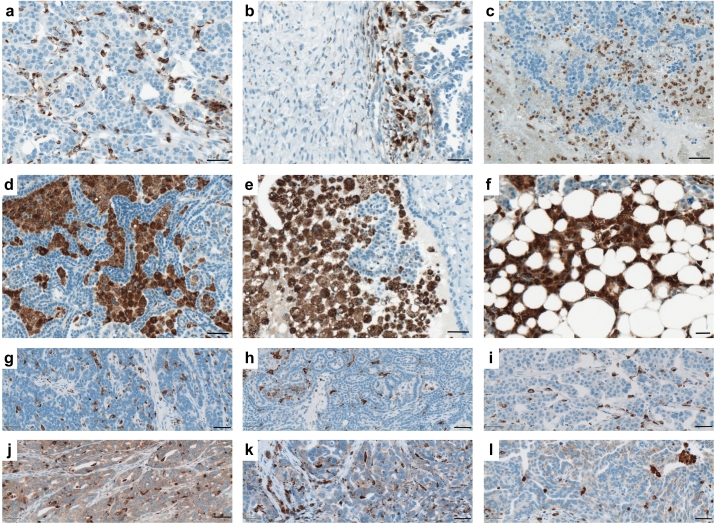
Localization patterns and morphology of CD68-positive cells of the monocyte/macrophage lineage at tumor site and the CD68 expression by tumor cells. Immunohistochemical staining of tissue sections that were obtained from patients with serous ovarian cancer. CD68 belongs to the lysosomal/endosomal-associated membrane glycoprotein (LAMP) family and primarily localizes to lysosomes and endosomes with a smaller fraction circulating to the cell surface. Representative images of various sub-populations of CD68-positive leukocytes are shown: (a) elongated well-spread intra-tumoral macrophages, (b) macrophage accumulation at the tumor – stroma border, (c) accumulation of round shaped monocytes in mucous tissue, (d,e) large phagocytes organized into phagocytic islands, (f) accumulation of macrophages in adipose tissue. Expression of CD68 by tumor cells: representative images of ovarian cancer specimens (n = 6) showing (g-i) the absence or (j-l) presence of CD68 expression by tumor cells. Brown color, CD68 staining; blue color, nuclear counterstaining with hematoxylin. Scale bar: 50 μm. (For interpretation of the references to color in this figure legend, the reader is referred to the web version of this article.)